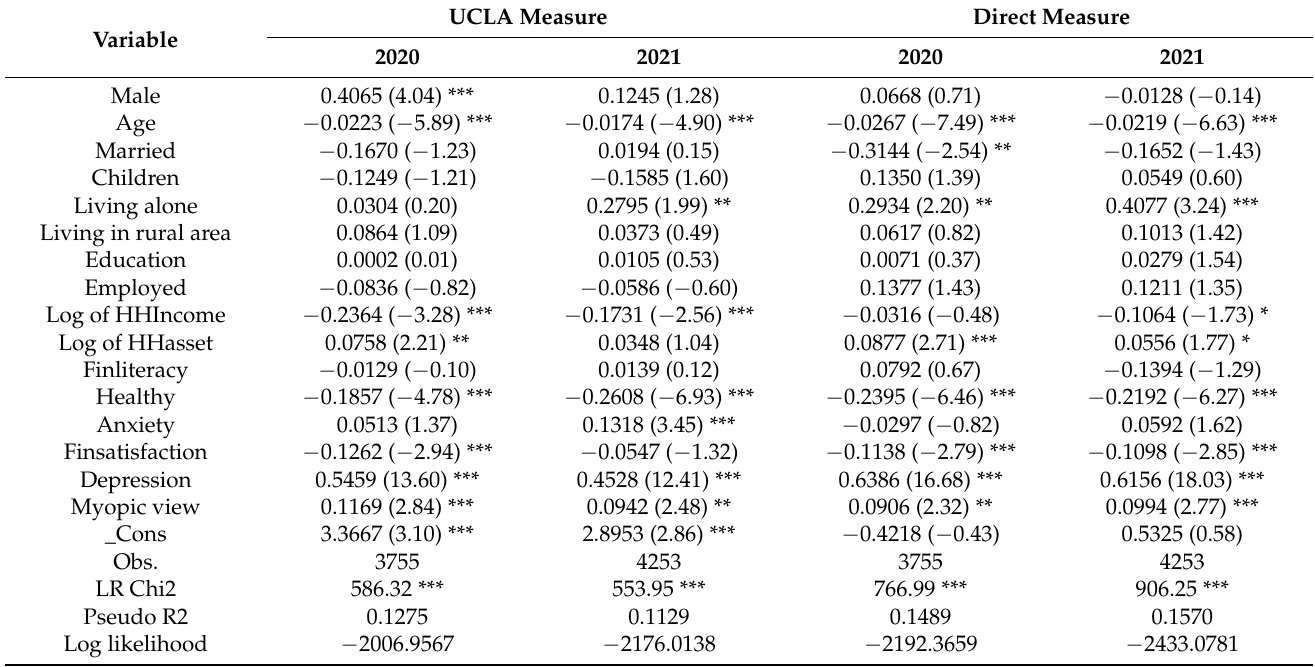
Table 4. Logit regression analysis for loneliness before and during the COVID-19 pandemic. UCLA Measure Direct Variable